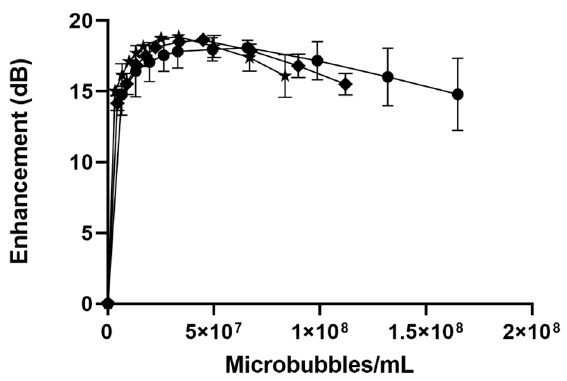
Figure 4. Effect of dual drug loading method on dose-response (plotted as microbubble/mL) curves for unloaded (- ● -), LP1 (- ◆ -), and LP2 (- ✮ -) SE61 O2 microbubbles.